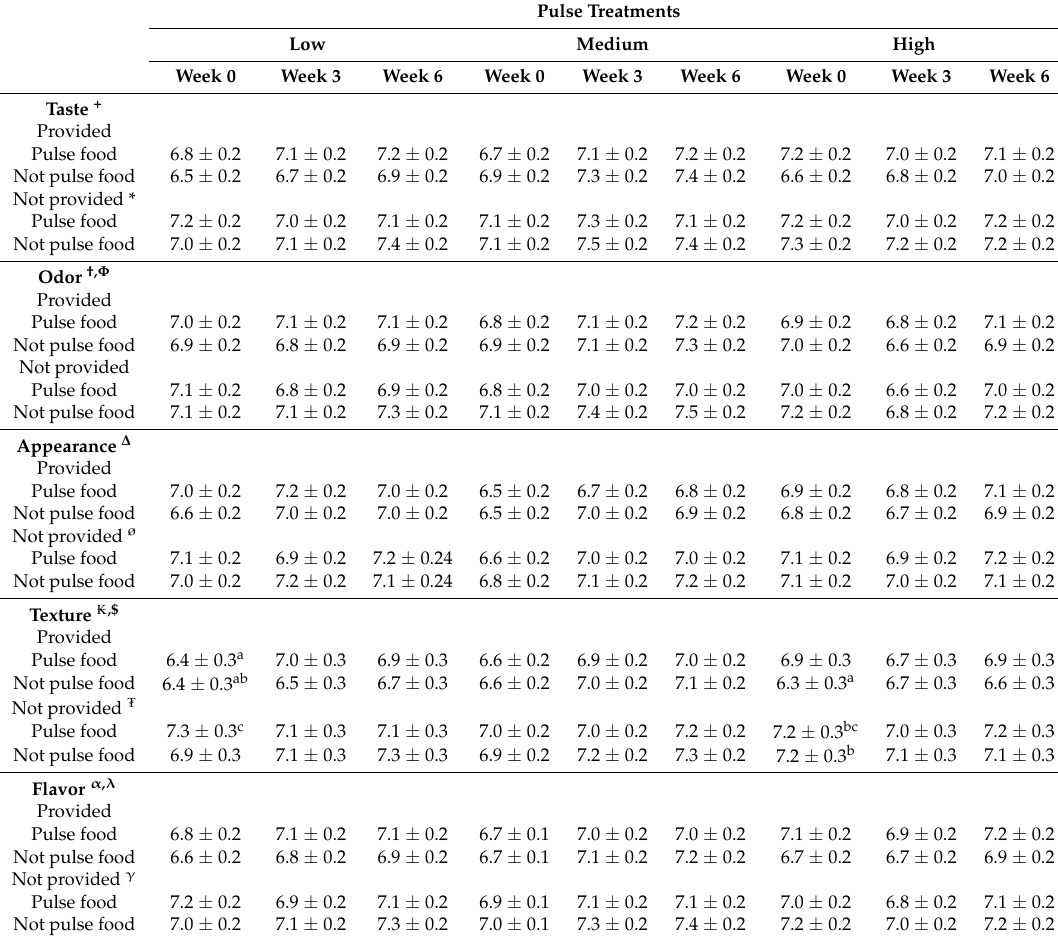
Table 2. Taste, odor, appearance, texture, and flavor pleasantness ratings by exposure type (provided or not provided as part of the intervention), food type, and pulse treatment groups and week of intervention (least square mean ± standard error of the